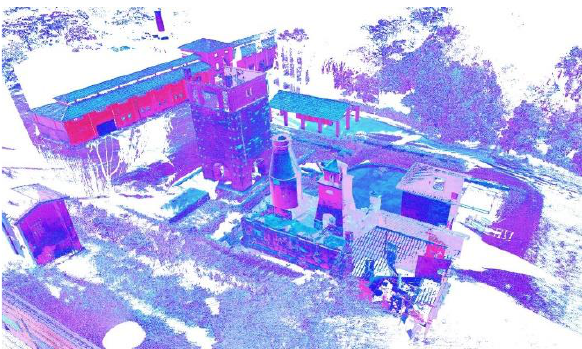
Figure 5: point cloud elaboration of the scanned area at Ipanema factory (in the centre, are visible the two furnaces and their external shape).